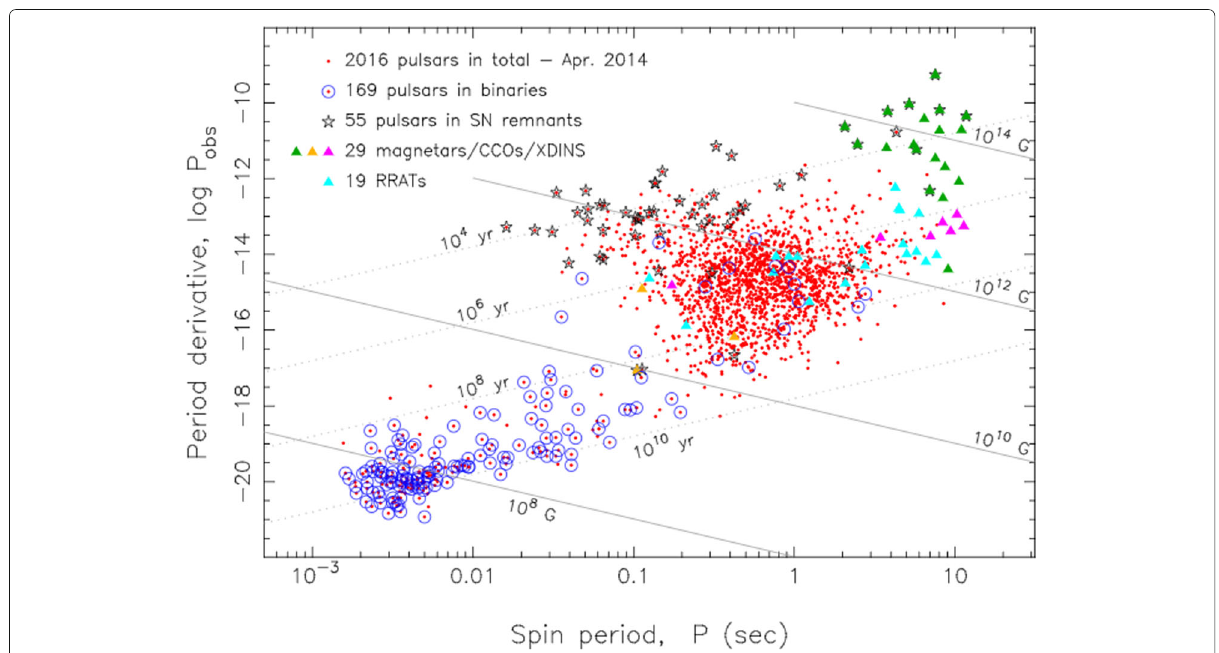
Fig. 1 Distribution of rotation period and its time variation rate of known pulsars together with the contours of characteristic age and magnetic field. Taken from